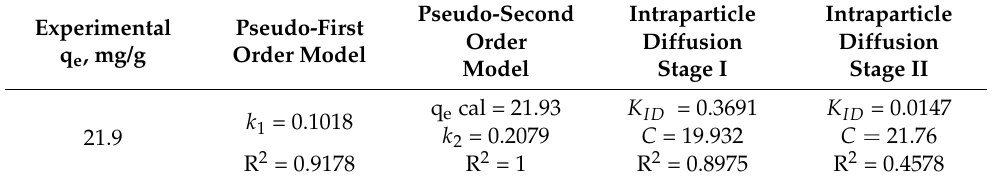
Table 4. Kinetic